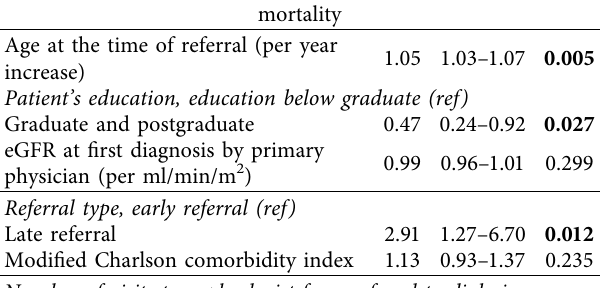
Table 5: Multivariate cox regression analysis showing independent variables associated with